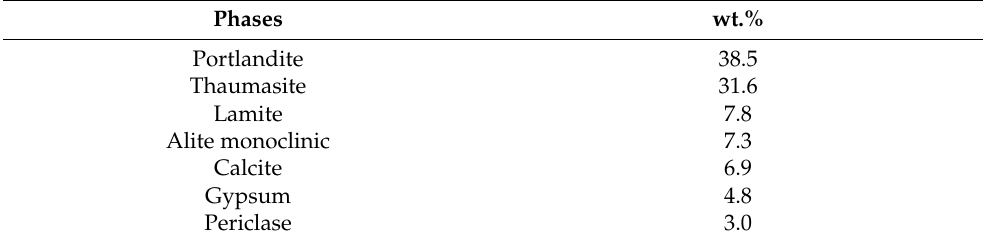
Table 1. Quantification of crystalline phases in Cement dust from XRD.